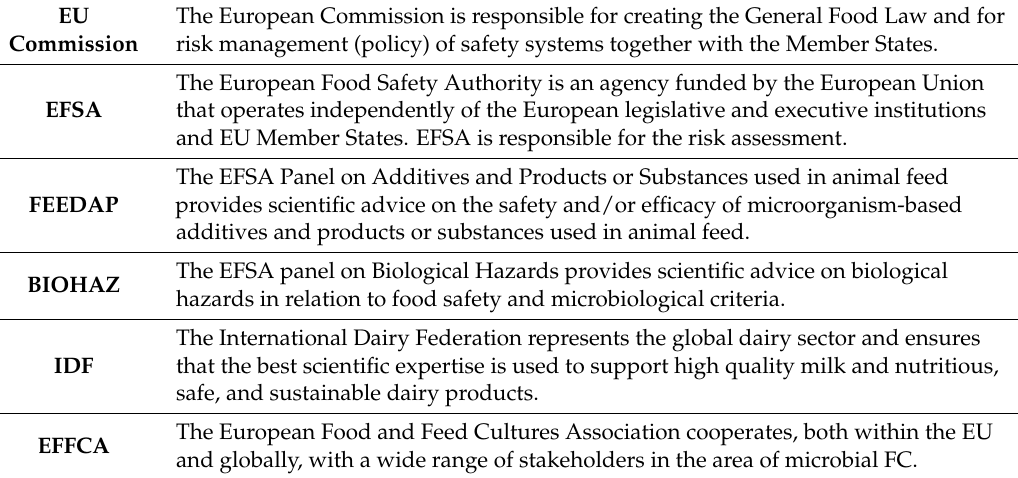
Table 1. Role of the main entities involved in the food cultures (FC) safety assessment in the European Union